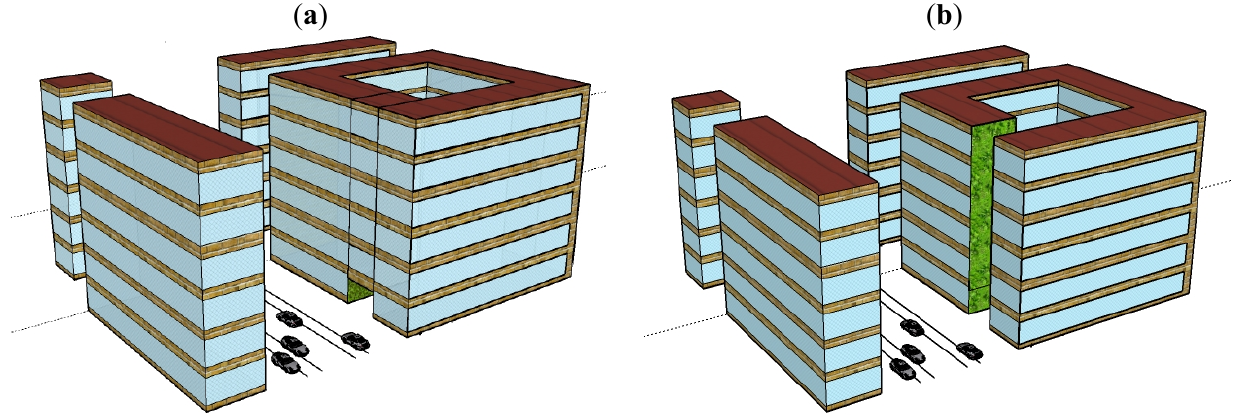
Figure 1. ( a ) Green walls at the entrance to an inner courtyard covering 58 m 2 , on a block of flats, six storeys high, with eight apartments on each floor; ( b ) Green walls at the entrance to an inner courtyard covering 369 m 2 facade, on a block of flats, six storeys high, with eight apartments on each floor (Source: [51]).